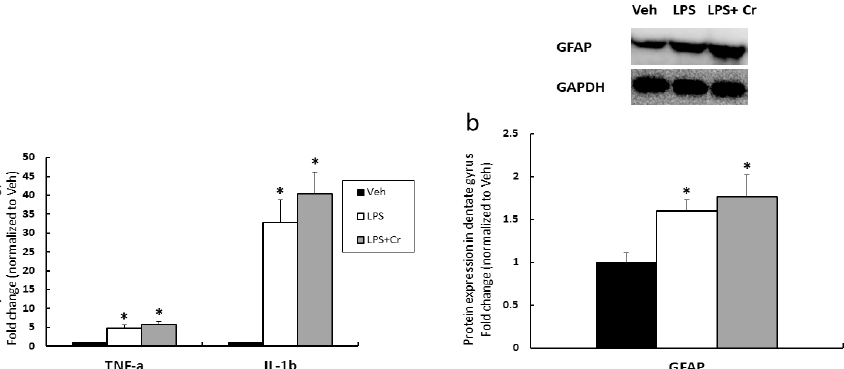
Figure 2. Proinflammatory markers and marker for the activation of astrocytes in the dentate gyrus of Veh, LPS, and LPS + Cr groups. ( a ) Proinflammatory TNF- α , IL-1 β mRNA expression level in the dentate gyrus. ( b ) GFAP protein expression in the dentate gyrus. Results are presented as mean ± SEM ( n = 8). * p < 0.05 significantly different from Veh group.